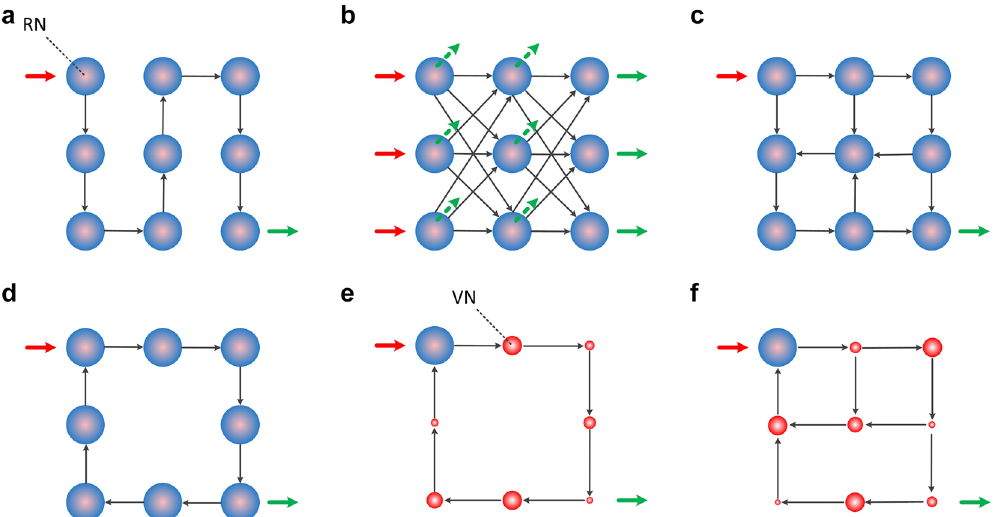
Figure 1: Different topologies in photonic neuromorphic computing, using physical nonlinear elements (real nodes, RN) and feedforward (a) and (b) or recurrent connectivity (c) and (d). In simpli fi ed schemes with a single physical nonlinear element and temporal delay (e) and (f), the dimensionality of the state space increases by considering weighted virtual nodes (VN). Links are unidirectional. RNs may introduce identical or different nonlinear functions. VNs are represented by different sizes to annotate their different weighing impact. Red arrows annotate the input signal. Green arrows annotate the RN or VN responses that are used for